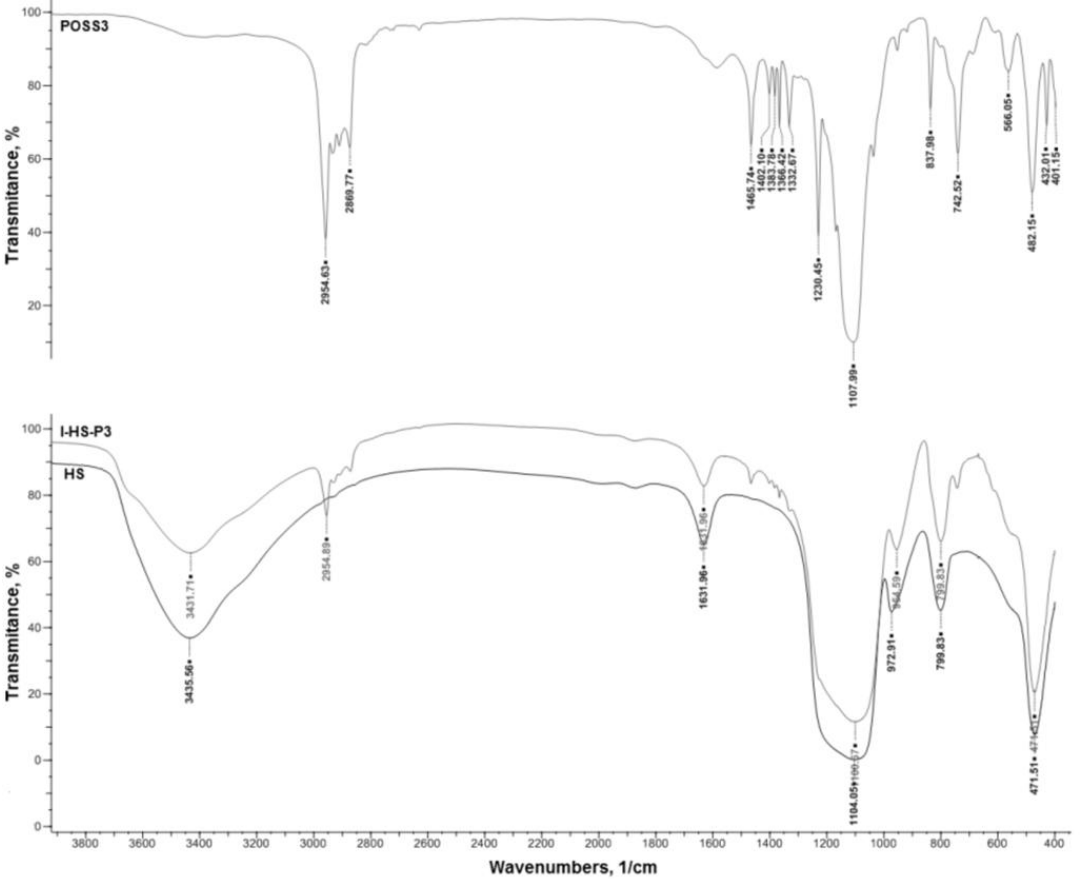
Figure 5. FTIR spectra of pure aminoethylaminopropylisobutyl POSS (POSS3) ( a ), unmodified hydrated silica (HS), and a hybrid prepared on its basis, grafted with 20 wt.% of N POSS (I-HS-P3) ( b